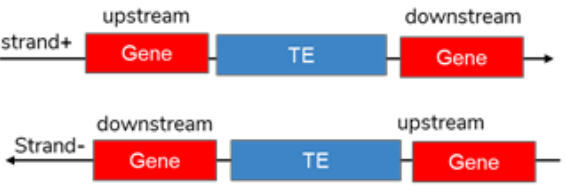
Figure 3. Representation of downstream and upstream genes based on autonomous TEs’